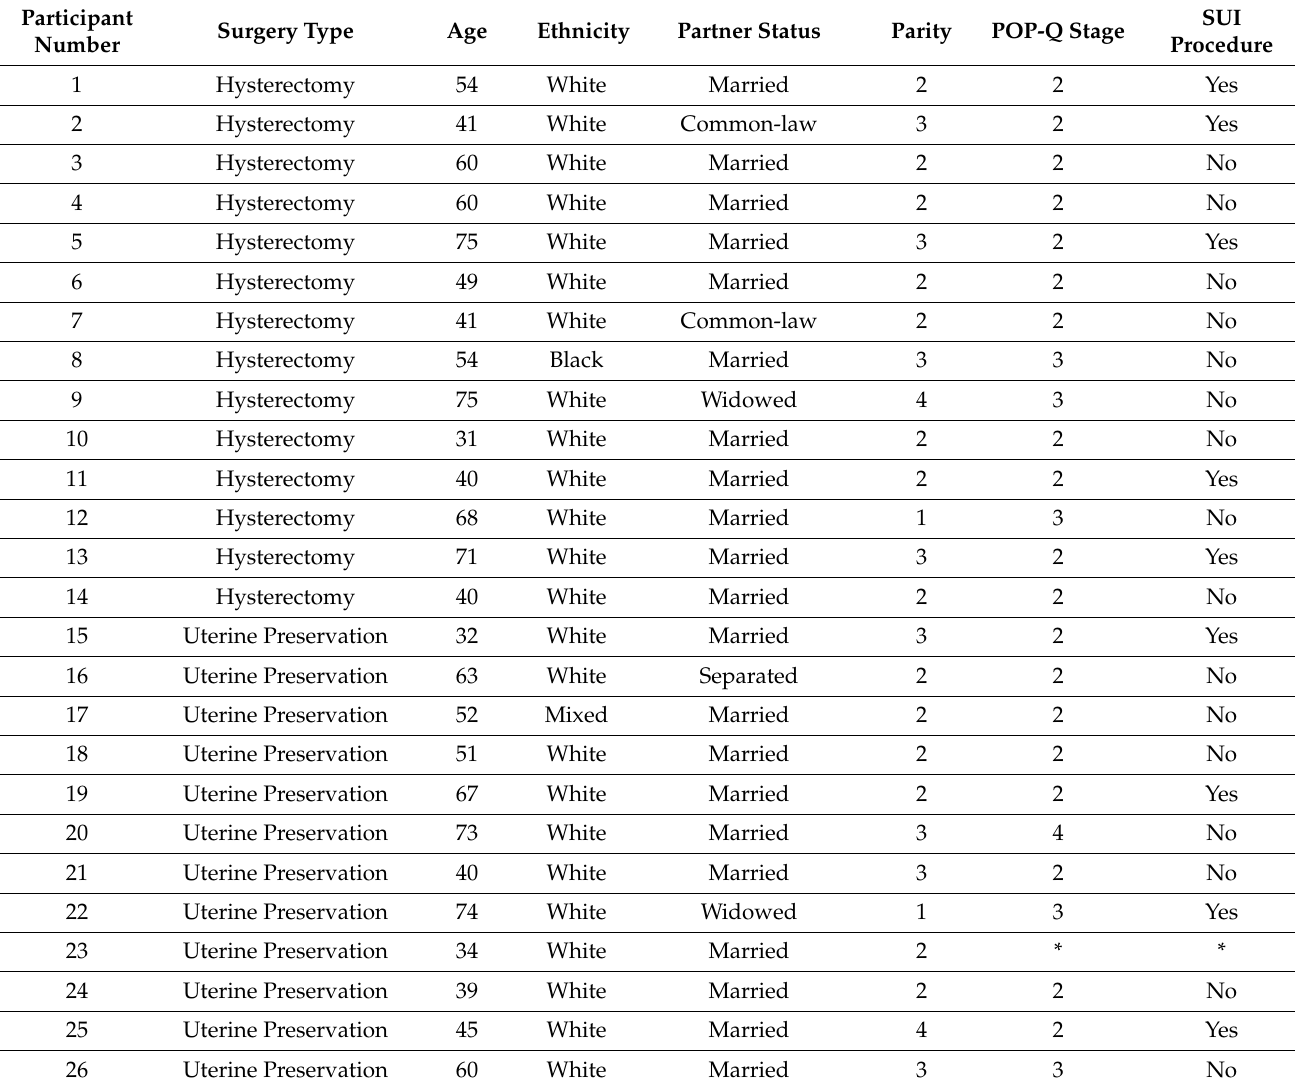
Table 1. Demographic and Surgical Characteristics of